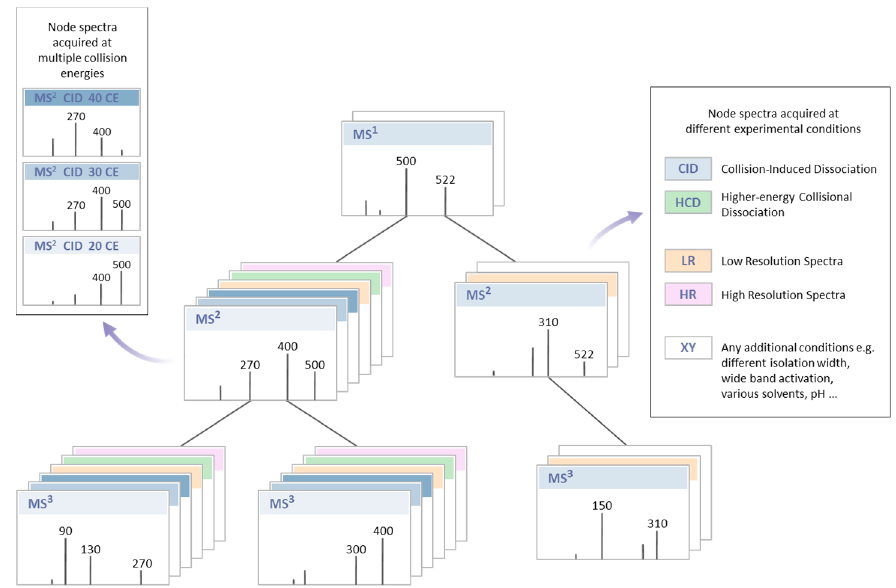
Figure 1. In tandem mass spectrometry, a spectral tree is a data structure encapsulating the hierarchically organized product ion mass spectra of a single chemical compound where each level represents an MS n stage. Edges refer to precursor m / z values, and nodes refer to spectra generated from the particular precursor ions.